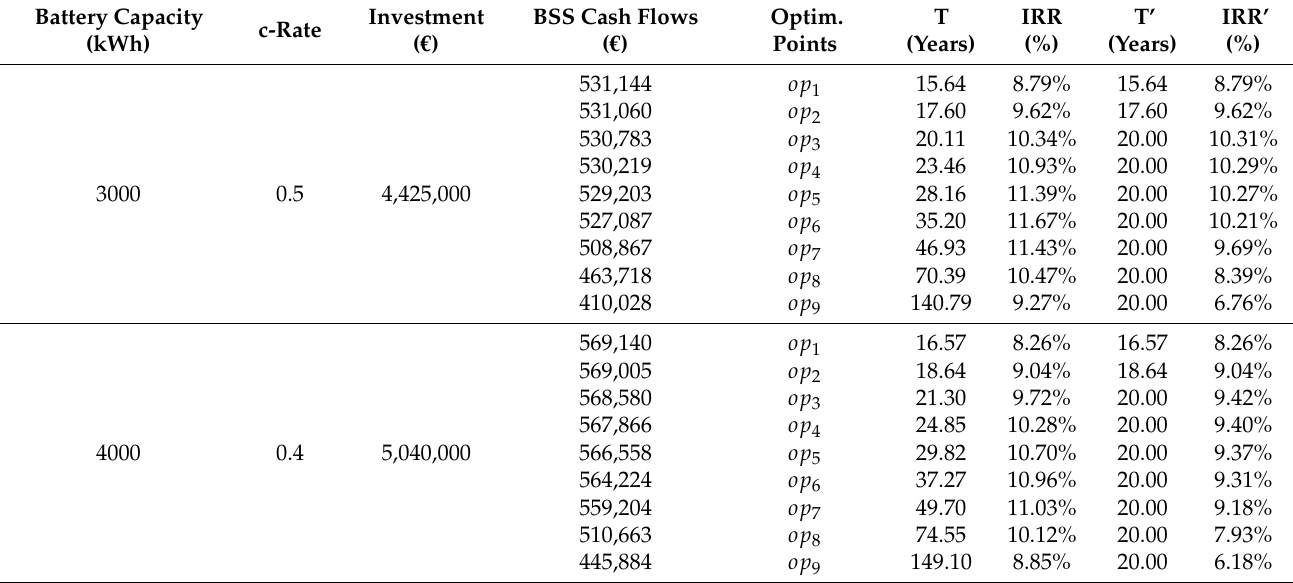
Table 2. MOO effects for c-rates 0.4 and 0.5 in 2017.